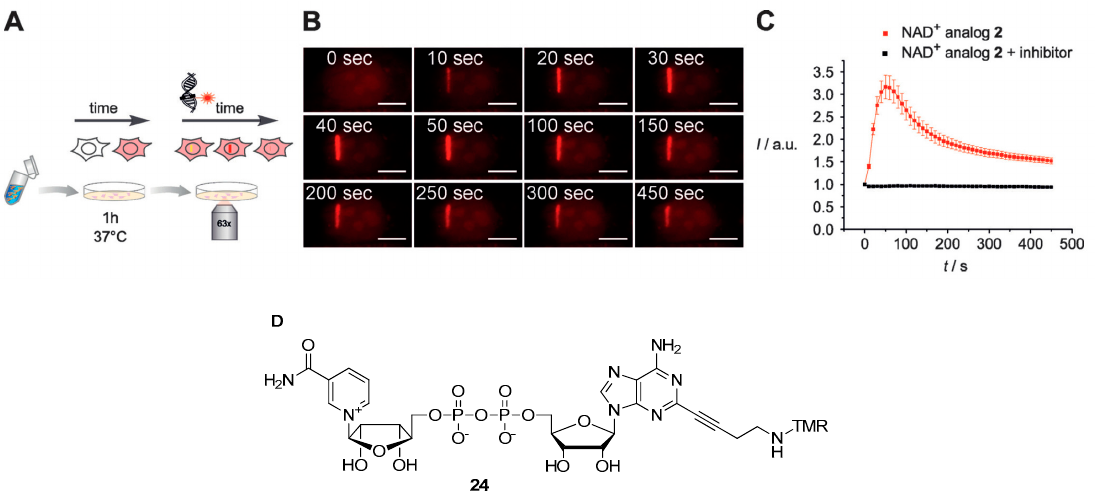
Figure 3. NAD + analogs used as substrates for protein ADP-ribosylation studies. A ) The idea of chemoenzymatic ADPR-ribose labelling using modified NAD + analogs; B ) NAD + modification sites (in purple, orange, and green) explored in the literature so far; C ) overview of analogs tested in this application.